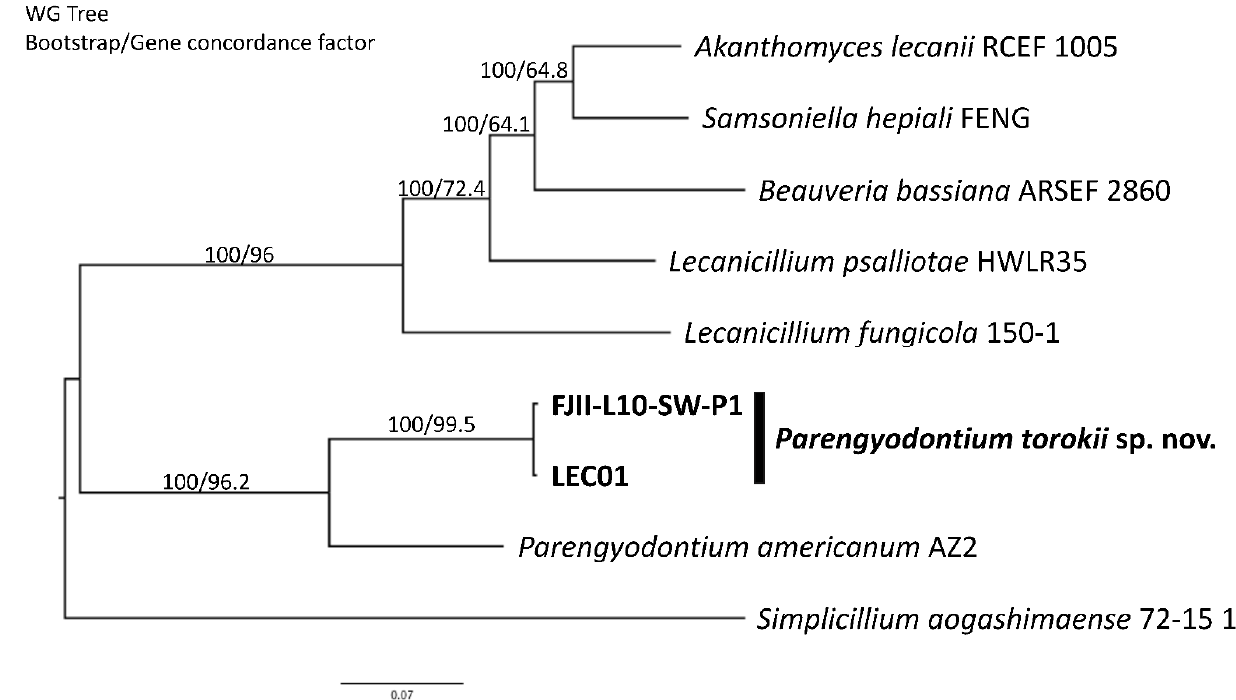
Figure 4. Phylogenomic analyses of Parengyodontium torokii . A total of 5334 single copy ortholo- gous genes were used to build up a Maximum Likelihood tree among 9 Cordycipitaceae fungi using the IQTREE2 software. Simplicillium aogashimaense was set as the outgroup and the branches are proportional to the number of mutations. Branch fidelity used two different approaches, Ultrafast bootstraps and Gene Concordance Factors, which were added next to its corresponding branches.